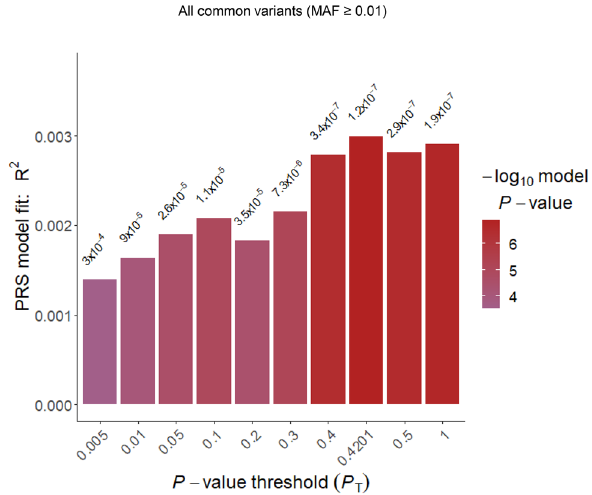
Figure 2. Evaluation of predictive power of PRS derived from all common variants on Geisinger ischemic stroke. PRSs were derived from MEGASTROKE by PRSice-2. LD-clumping using the following PLINK command: –clump-p1 1, –clump-kb 1000, –clump-r2 0.3 was applied to all common variants, resulting in 231,307 SNPs for p-value thresholding in the MyCode IS (n = 1756) versus non-IS (n = 19,806) patients. The results were derived over a range of p value thresholds. Nagelkerke pseudo- R 2 as shown in the Y-axis, represents how much variation is explained by the model. the X-axis represents the threshold for a base p value. P value on the top of each bar represents the probability of non-zero regression coefficient with the F statistic hypothesis testing of the fit of the intercept-only (PRS excluded) model and PRS included model are equal. The regression model was adjusted by the covariates including sex, and the five main principal